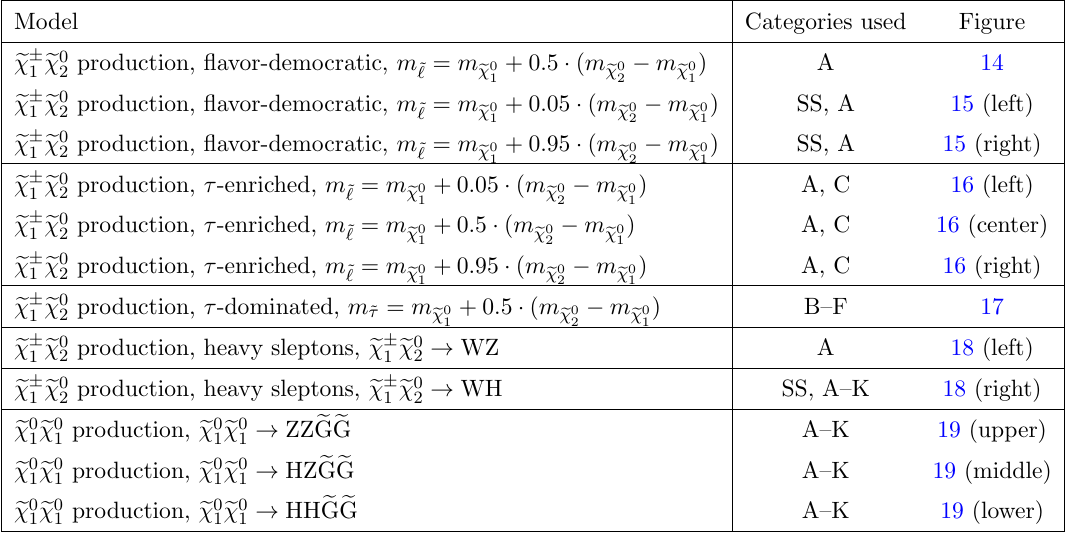
Table 20 . Summary of the interpretations of the results using di(cid:11)erent